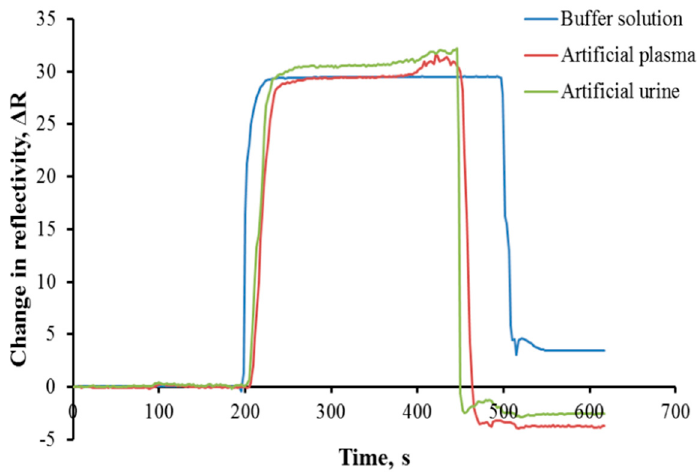
Figure 7. Real-time sensorgrams of AuNP-MIP plasmonic sensor for complex samples. Cortisol concentration: 100 ppb; adsorption solution: PBS-ethyl alcohol (50:50, v / v ); interaction time: 10 min; flow rate: 0.2 mL/min; T: 25 °C.